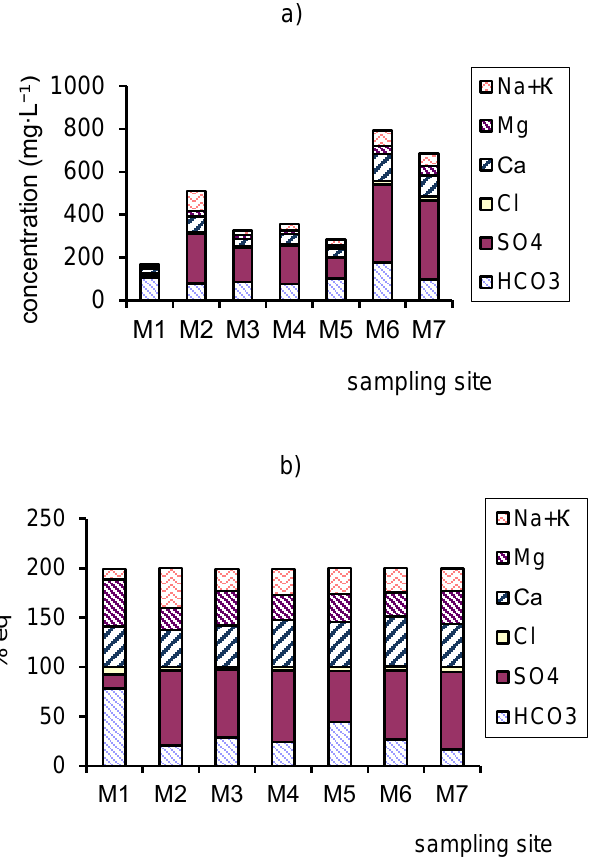
Figure 3. Variation of the concentration major ions ( a ) and its the equivalent fraction content ( b ).